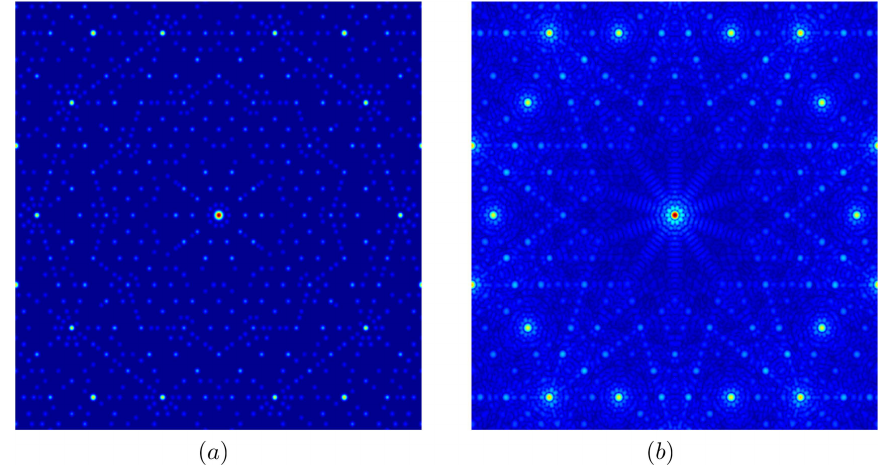
Figure 10. ( a ) Square root of the normalized FS harmonics (magnitude) of the Penrose QC obtained using the expansion of the 4D hyper-lattice; ( b ) square root of the normalized FT (magnitude) of a Penrose